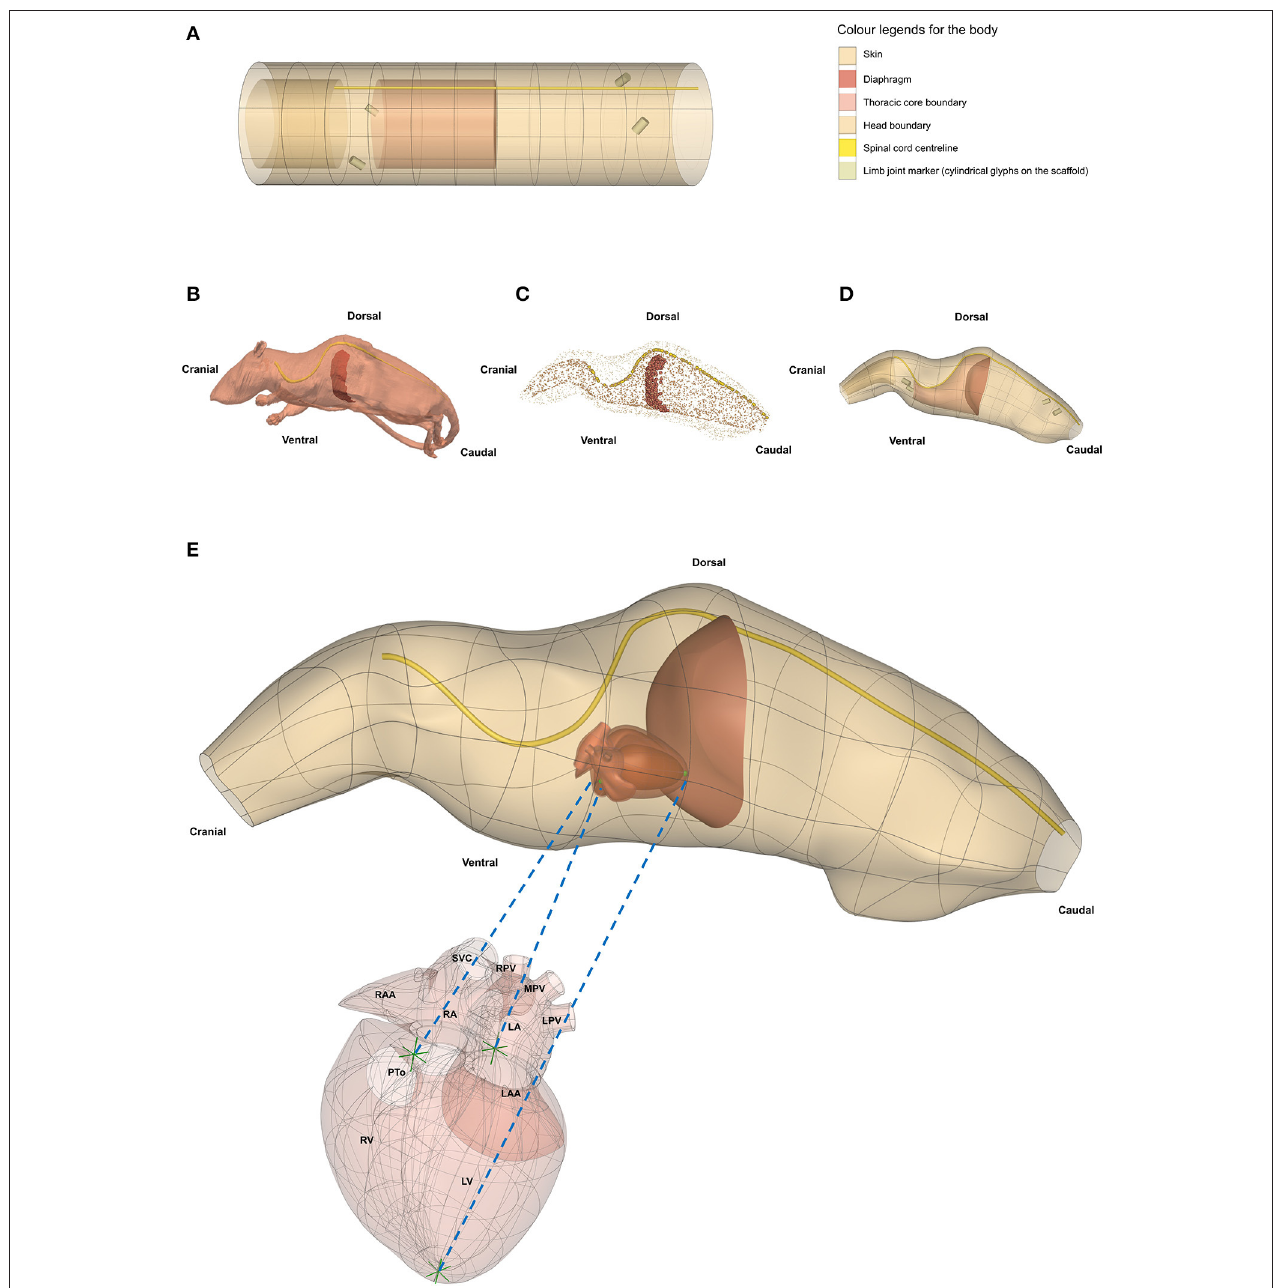
FIGURE 8 | Generating a whole rat body anatomical scaffold from data for integration with other organ scaffolds. (A) The 3D body coordinate system (dataset available from https://sparc.science/datasets/112) shows distinct anatomical regions with different colors. (B) The rat model (NeuroRat, IT’IS Foundation. doi: 10.13099/VIP91106-04-0) in the vtk format with spinal cord and diaphragm visible. This model contains 179 segmented tissues with neuro-functionalized nerve trajectories (i.e., associated electrophysiological fiber models). (C) All tissue tissues from the rat body were resampled and converted into a data cloud to provide the means for generating the whole body scaffold. The data cloud is a 3D spatial representation of the tissue surface consisting of a certain density of points in the 3D Euclidean space. These points are used to define the objective function for the scaffold fitting procedure. The data cloud of the skin, inner core, spinal cord, and diaphragm are shown in (C) with the limbs and tail excluded. (D) The 3D body scaffold (A) was fitted to the rat data to generate the anatomical scaffold. (E) A generic rat heart scaffold was projected into the body scaffold using three corresponding fiducial landmarks (green arrows in heart and green spheres in the body). This transformation allows embedding of the organ scaffolds into their appropriate locations in the body scaffold, providing the required physical environment required for simulation and modeling. SCV, superior vena cava; RPV, right pulmonary vein; MPV, middle pulmonary vein; LPV, left pulmonary vein; RAA, right atrial appendage; RA, right atrium; LA, left atrium; LAA, left atrial appendage; PTo, pulmonary trunk outlet; RV, right ventricle; LV, left ventricle.